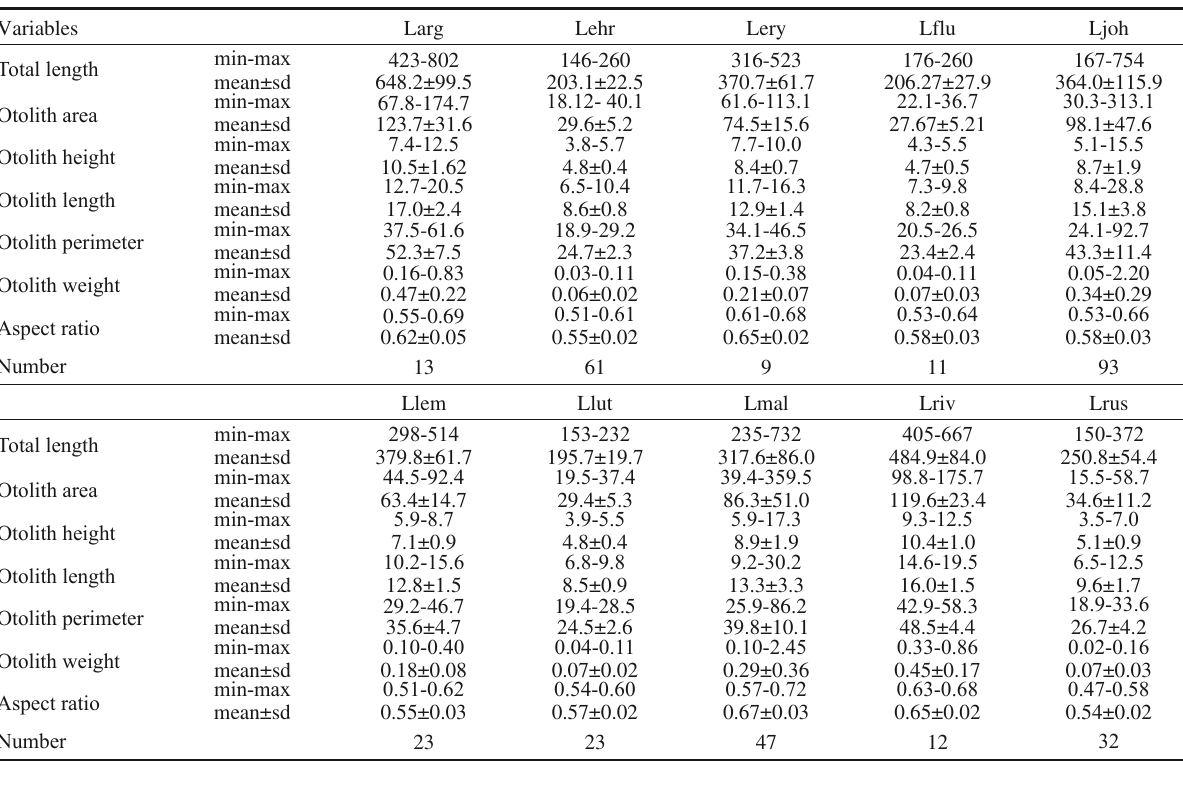
Table 1. − Summary of descriptive statistics of fish length and otolith size of snappers from the Persian Gulf. L. argentimaculatus , Larg; L. ehrenbergii , Lehr; L. erythropterus , Lery; L. fulviflamma , Lflu; L. johnii , Ljoh; L. lemniscatus , Llem; L. lutjanus , Llut; L. malabaricus , Lmal;